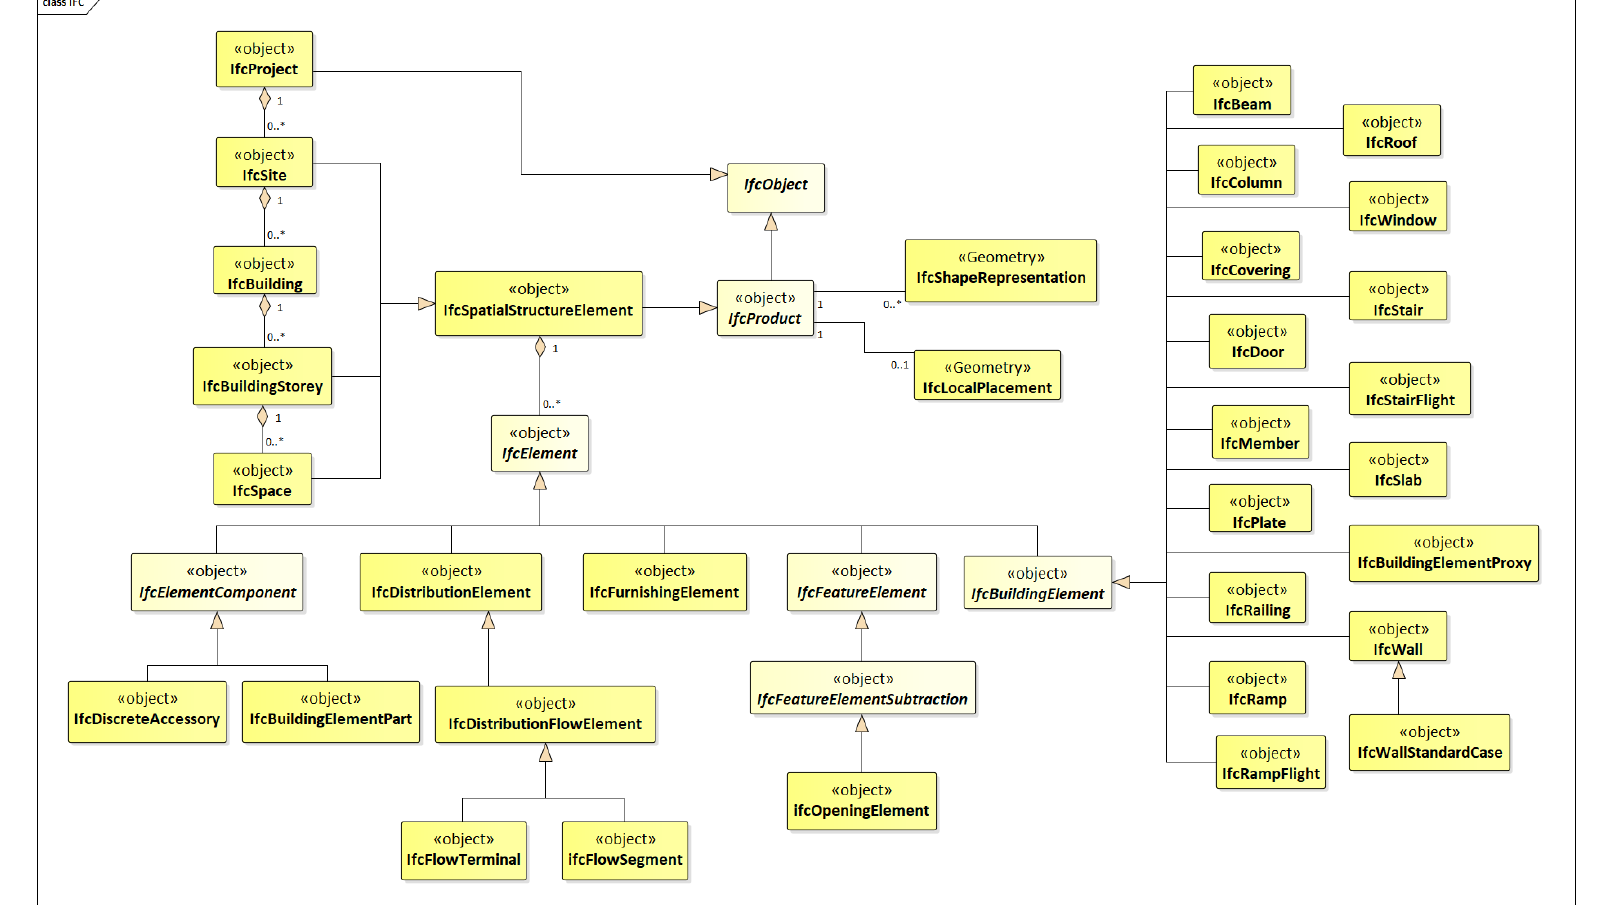
Figure A1. IFC building